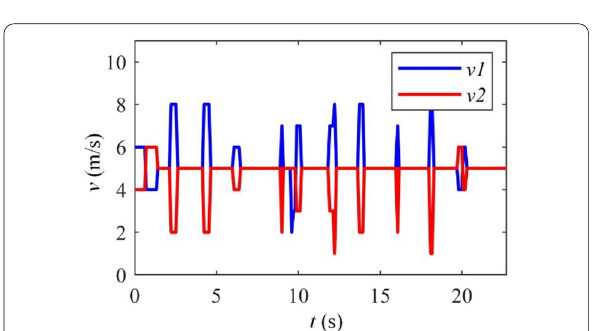
Figure 23 Velocity of two wheels in short distance